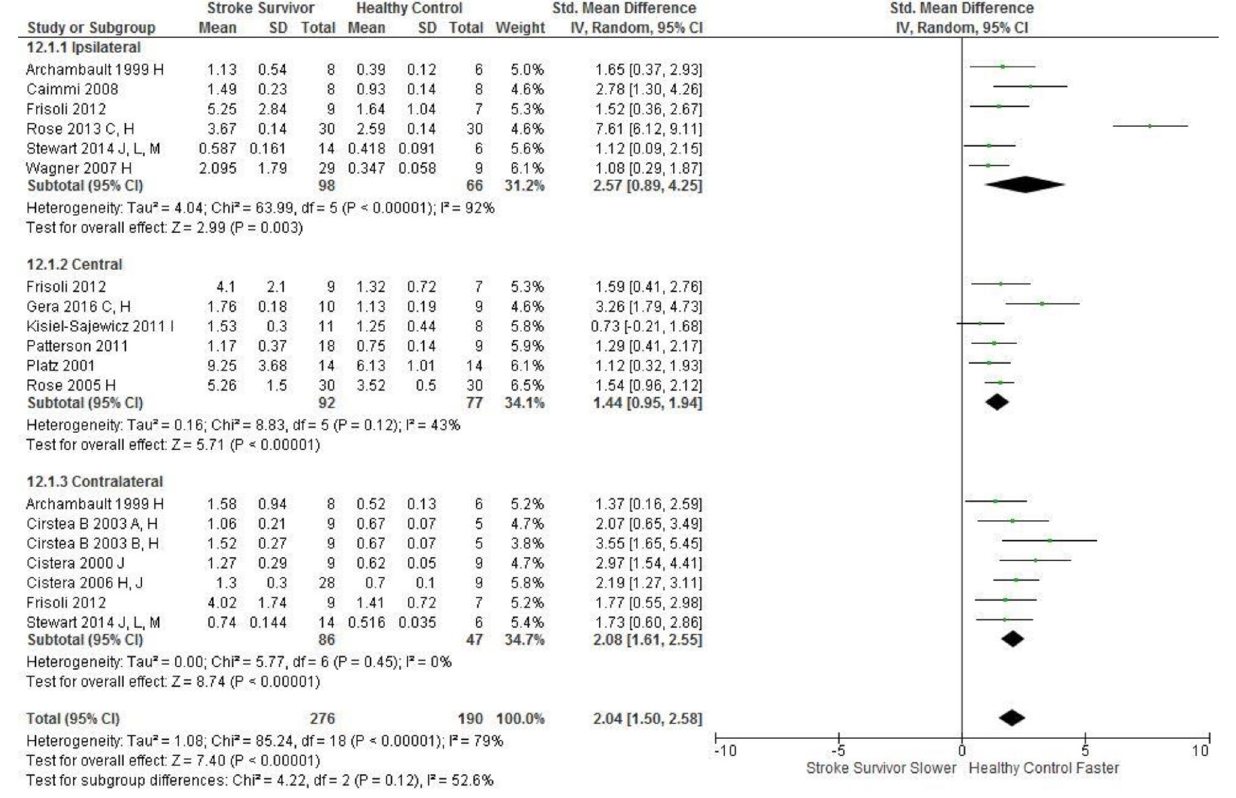
FIGURE 3 | The standardized mean difference (SDM) of movement time (s) during reach-to-target in the: ipsilateral, central, and contralateral workspace. A, mild motor impairment; B, moderate motor impairment; C, bilateral task; F, target placed 90% of arm’s length; C, bimanual task; H, fast speed; I, robotics; J, reaches without vision; L, 24cm target distance; M, virtual